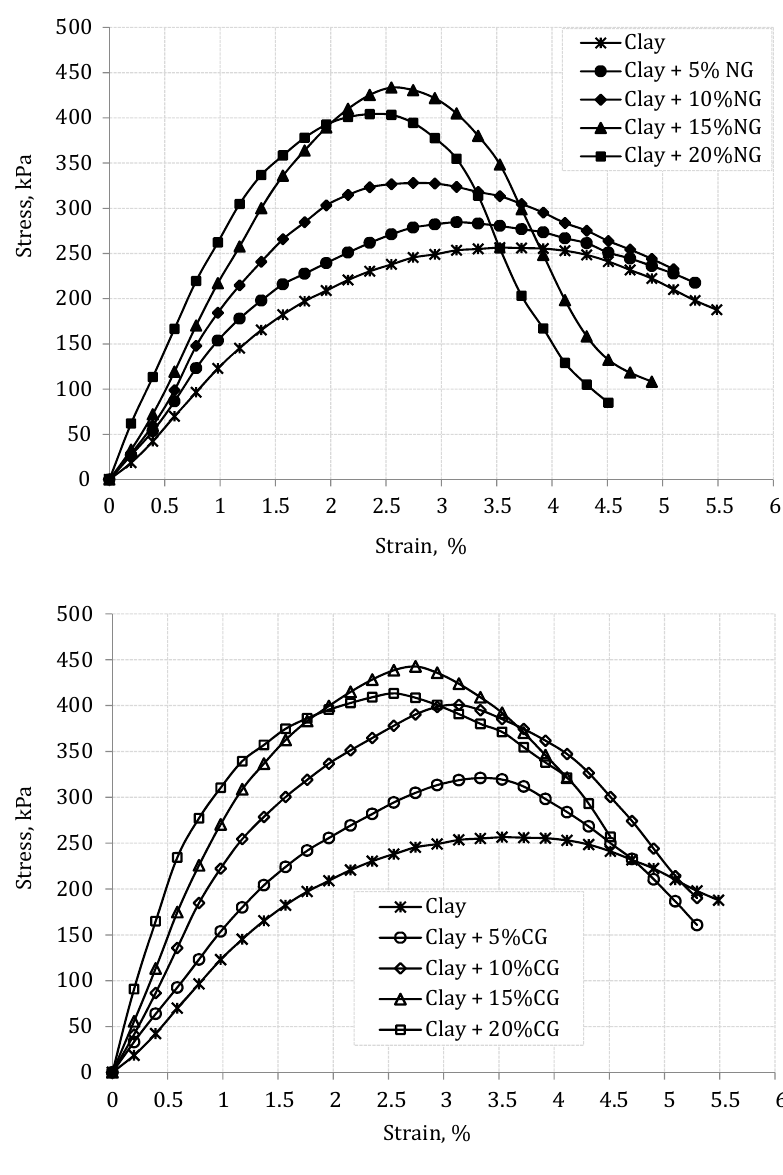
Figure 5. Stress-strain relationship for the clay with NG (top), and CG